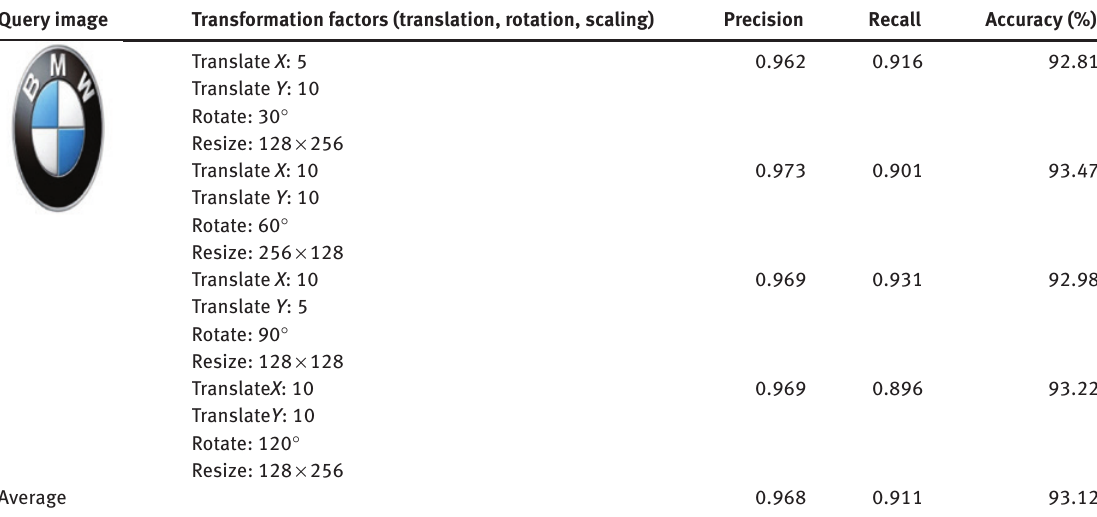
Table 5: Results in Terms of Precision, Recall, and Accuracy with the Transformed Query Image.